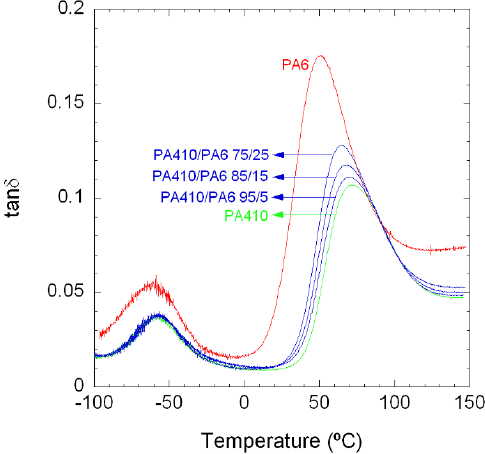
Figure 1. DMTA curves of neat PA410, PA6, and 95/5, 85/15, and 75/25 PA410/PA6 blends.